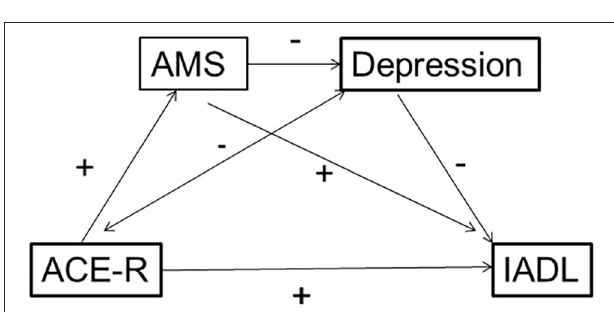
FIGURE 3 | Multiple mediation model showing the forward effect of autobiographical memory specificity (AMS) on depression, as mediators between a measure of cognitive function (ACE-R) and outcome Instrumental Activities of Daily Living (IADL), in a context where the mediation effect of AMS between ACE-R and IADL itself is not